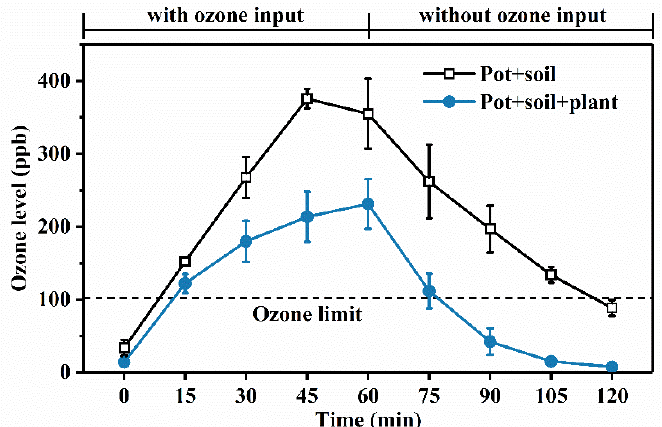
Figure 1. Time courses of ozone level within the sealed chambers. Treatments included pot with soil and pot, soil with E. japonicus, both covered with aluminum foil. The ozone generation lasted for 60 min, and error bars represent standard deviation ( n = 3). The dashed line refers to the ozone concentration limit (GB3095-1996).